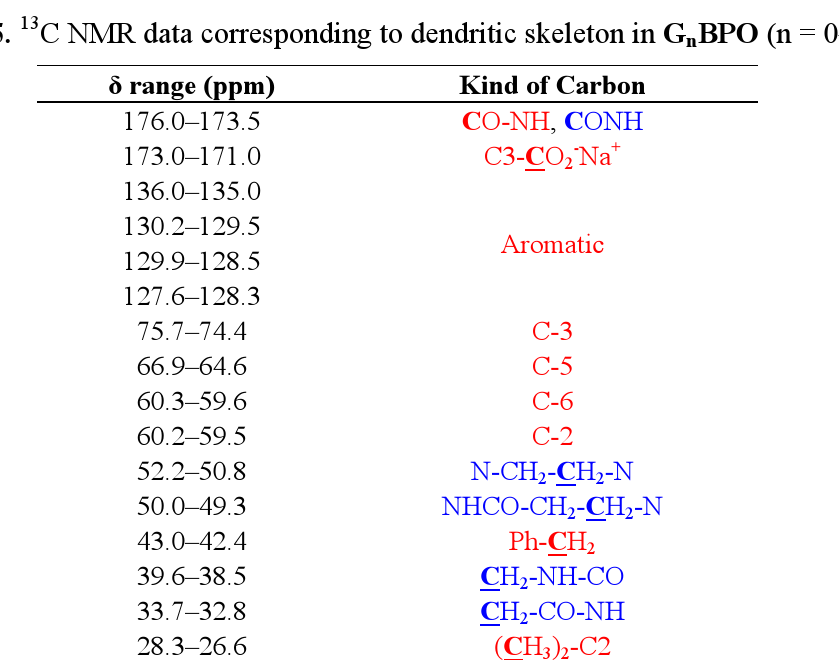
Table 5. 13 C NMR data corresponding to dendritic skeleton in G